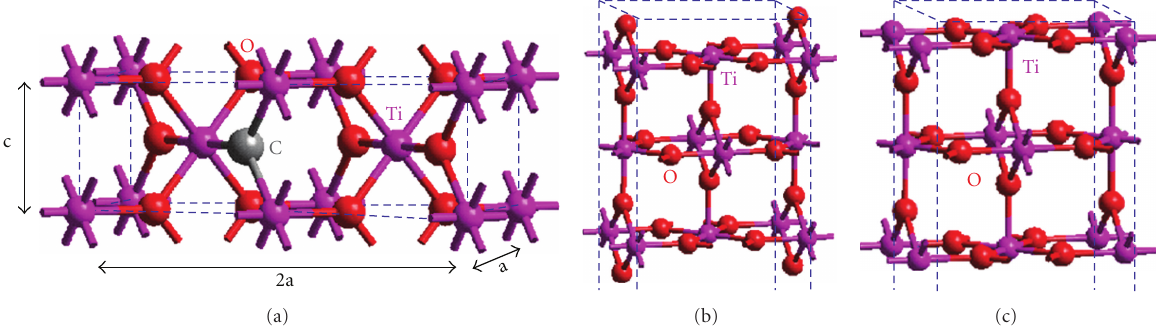
Figure 2: Unit cells used in present calculations. (a) 2 × 2 × 1 supercell (Ti 4 O 7 C) with substitutional carbon doping. (b) Stoichiometric (110) surface, (c) nonstoichiometric Ti–O termination of the (110) surface.